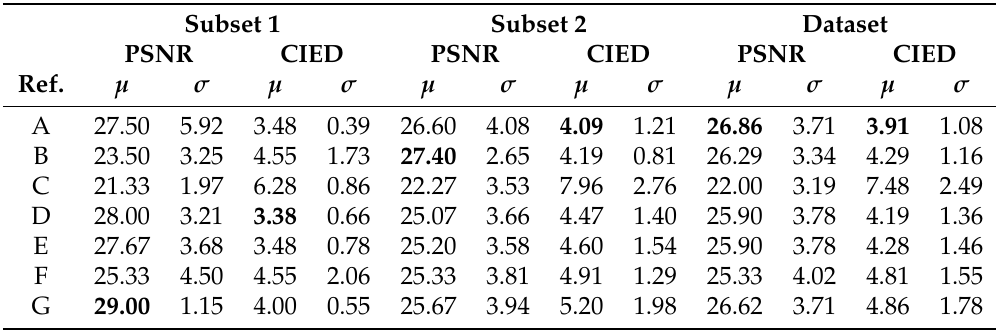
Table 6. Mean and standard deviation of the PSNR, CIEDE2000 (CIED) scores for each reference image selection, using algorithm #6. Best results highlighted in